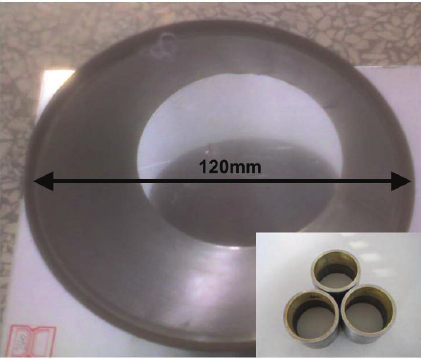
Figure 7: To be rolling bimetallic bush at 1150 ∘ C.